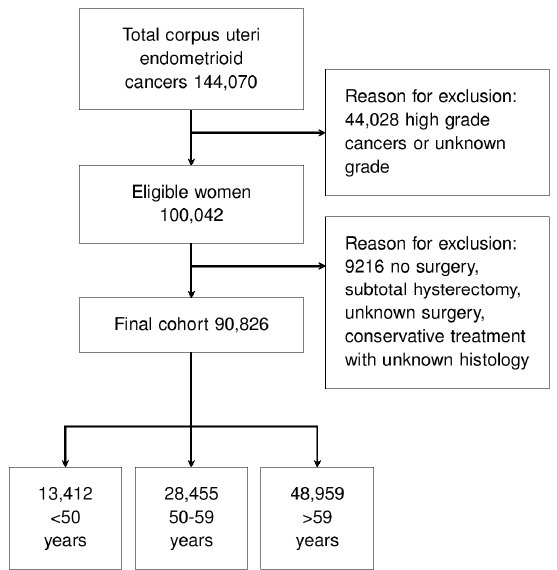
Figure 1. Study flow ‐